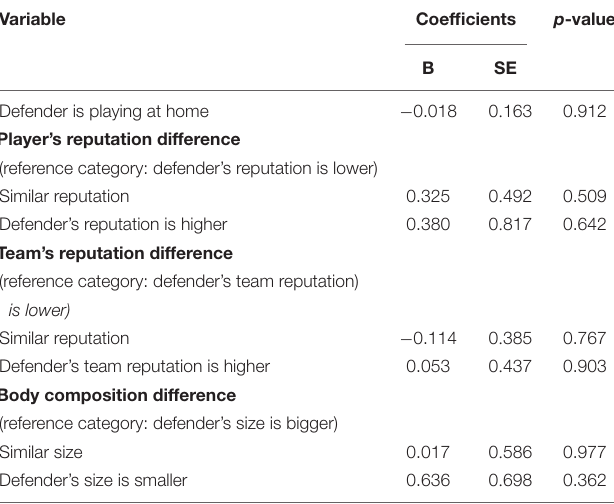
TABLE 6 | Logistic regression explaining the referee’s decision whether to call an offensive